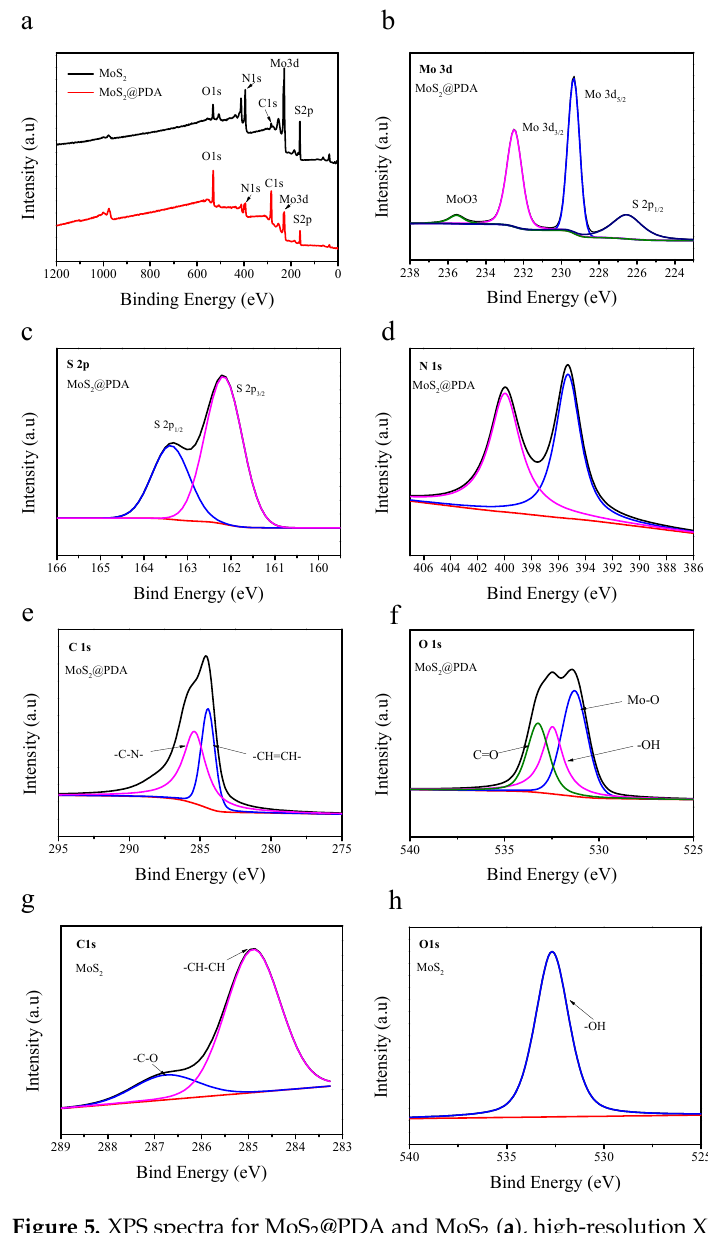
Figure 5. XPS spectra for MoS 2 @PDA and MoS 2 ( a ), high-resolution XPS spectra of Mo 3d ( b ), S 2p ( c ), N 1s ( d ), C1s ( e ), and O 1s ( f ) for MoS 2 @PDA and C1s ( g ) O 1s ( h ) for MoS 2 .